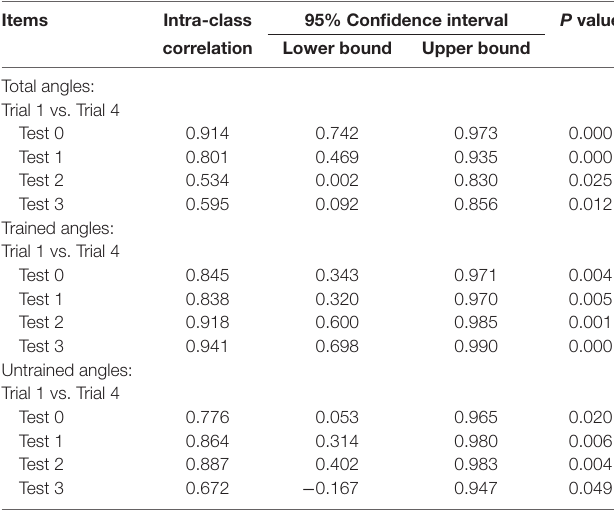
TABLE 2 | Result of test-retest reliability analyses for training